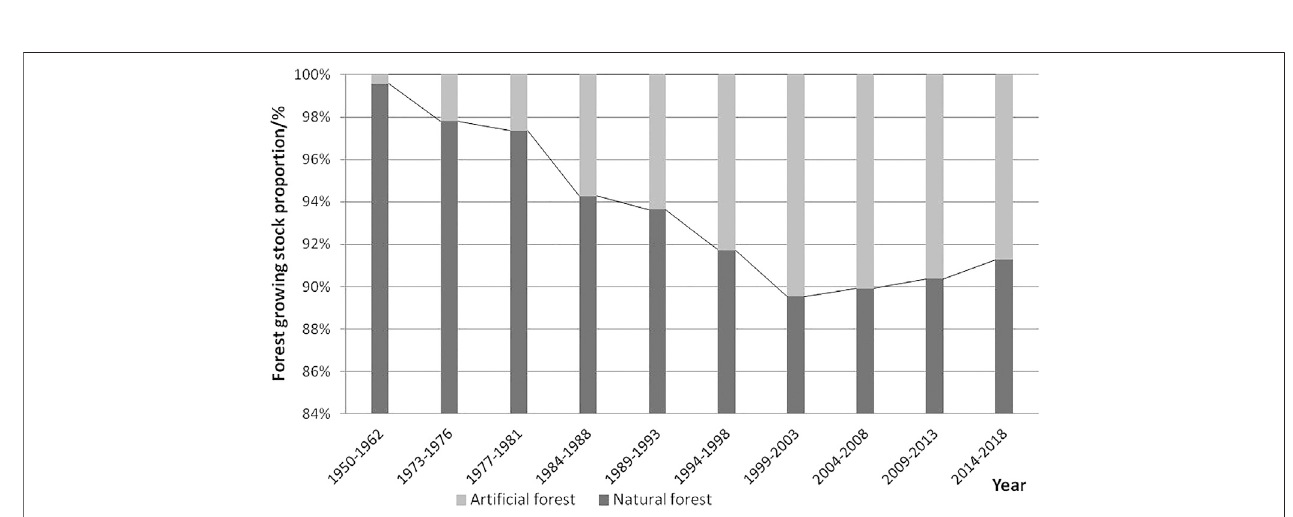
FIGURE 5 | Forest growing stock proportion of arti fi cial forest and natural forest.